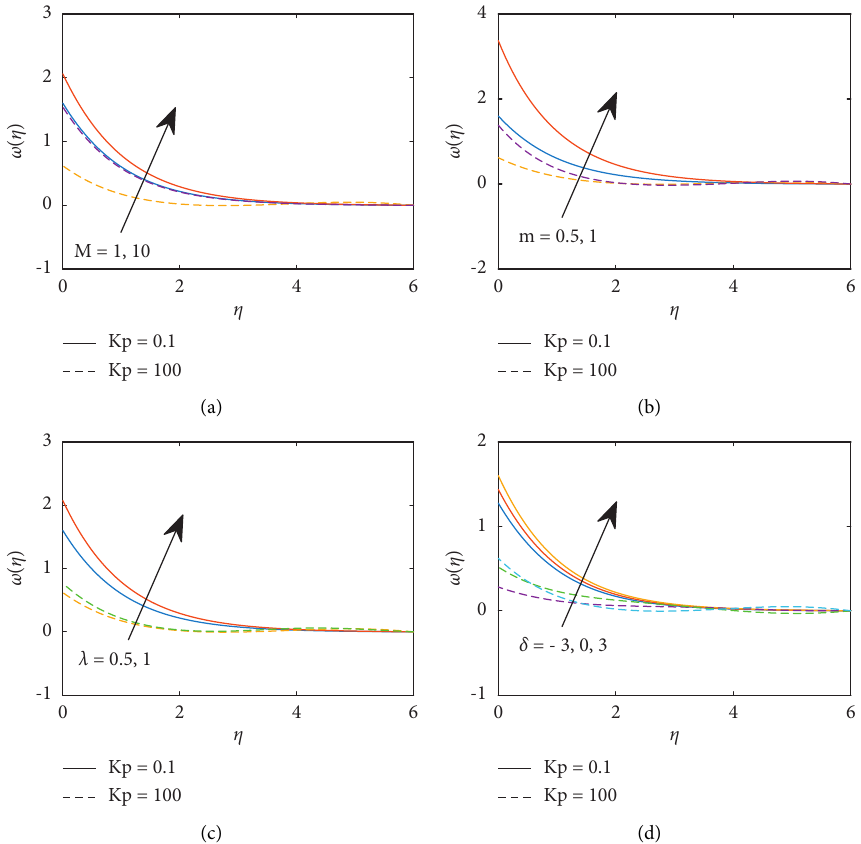
Figure 10: Impact of (a) M